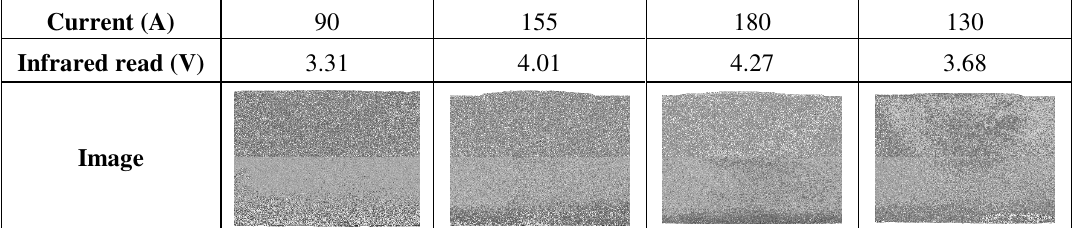
Table 2. Relation between infrared signal and weld penetration depth under different